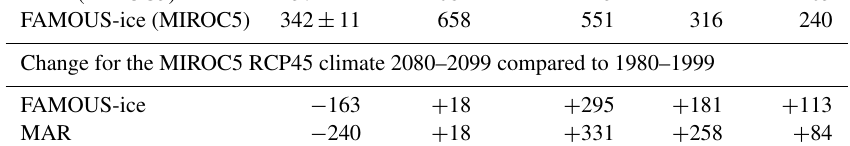
Table 1. Ice sheet averaged simulated surface mass balance and relevant components for Greenland in 1980–1999 (Gtyr − 1 LWE). MAR and RACMO data are from Fettweis et al. (2013) (using an earlier version of RACMO than that plotted in Figs. 2 and 5). ERA-Interim and ECMWF climate forcing for MAR and RACMO comes from Dee et al. (2011), and MIROC5 climate forcing comes from Watanabe et al. (2010). SMB is the total change in snowpack mass over a year. Ablation is the difference between snowfall and SMB, so it includes all processes that remove mass from the snowpack such as sublimation. Since FAMOUS-ice does not route rainfall through the snow, refreeze has been defined under the assumption that all of the rain falling on the snow has run off. The ± uncertainty shown for SMB is the standard error of the time mean, which was estimated by assuming annual values to be independent. Model SMB Snowfall Surface melt Ablation Refreeze RACMO (ECMWF) 406 ± 22 683 476 277 MAR